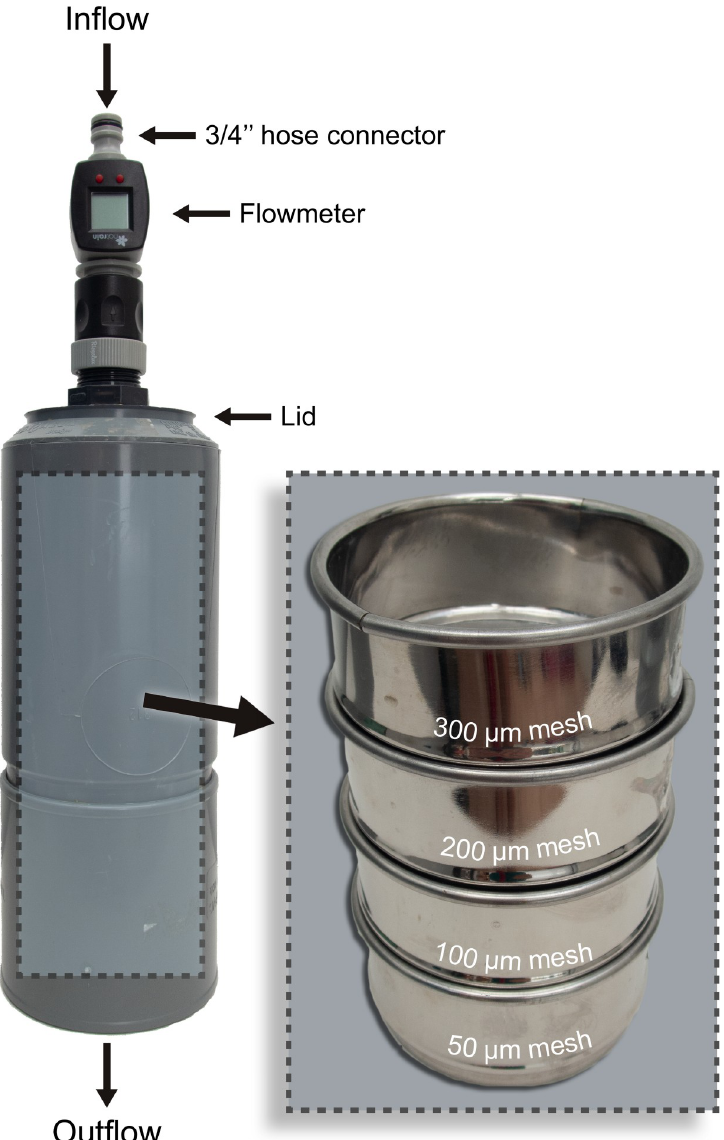
Fig 2. Sampling device diagram. The pump underway system of the RV A´ngeles Alvari ñ o had a tap connection at the wet lab to which the filtering device was connected with a ¾ ” hose. This figure shows real pictures of the sampling device used in this study, with the stacked sieves that it contains shown on the